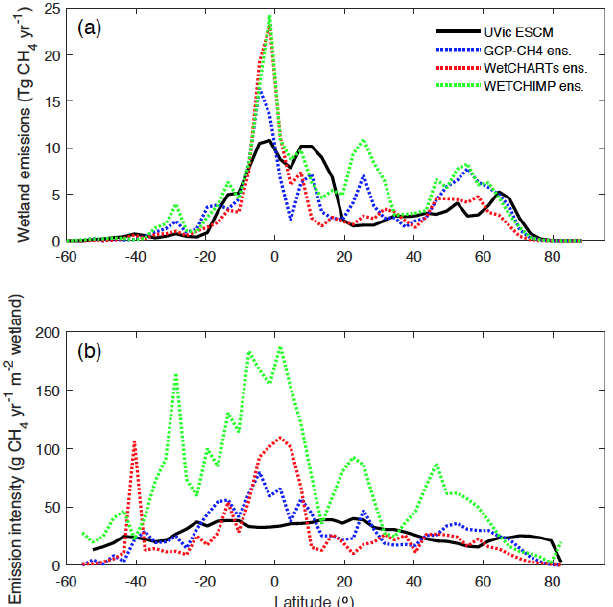
Figure 11. (a) Latitudinal distribution of wetland methane emis- sions simulated by the UVic ESCM over the 2001–2004 period in comparison to three process-based model ensembles: GCP-CH4, WetCHARTs, and WETCHIMP. The comparison period corre- sponds to the overlap period for the three model ensembles. (b) Lat- itudinal emission intensity (methane emissions per unit of wetland area) simulated by the UVic ESCM over the 2001–2004 period in comparison to the three process-based model ensembles. GCP-CH4 and WetCHARTs both use SWAMPS-GLWD as prescribed wet- lands. The wetland methane emissions and emission intensities are summed across latitude bins of 3 ◦